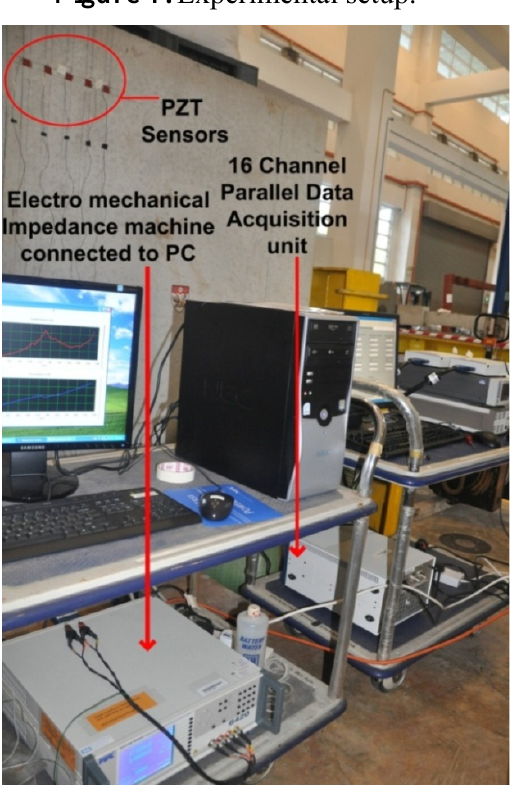
Figure 1. Experimental